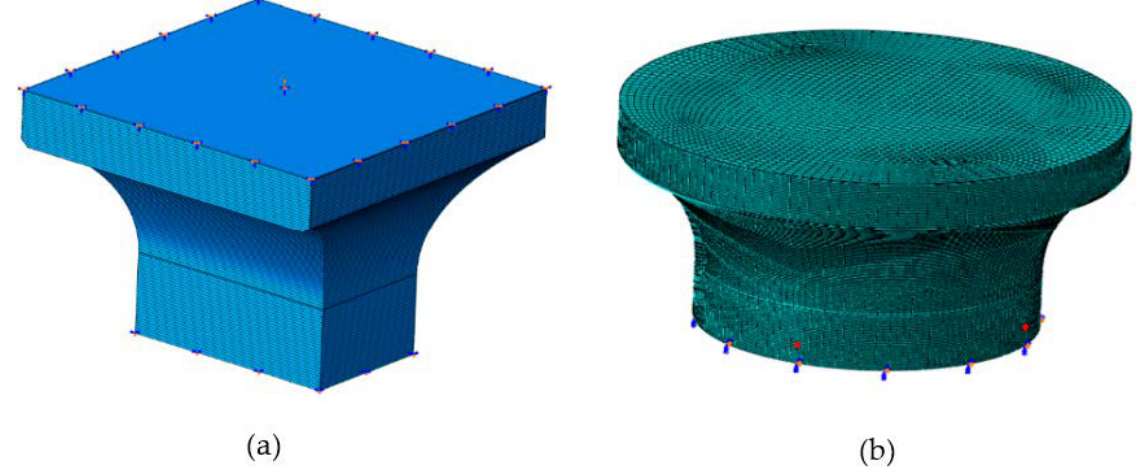
Figure 8. ( a ) Geometry of the RARDE Type III specimen showing the location of the loading node on the top face of the specimen, and ( b ) spool A model showing typical mesh, the symmetry boundary conditions, and the location of gauge nodes (red